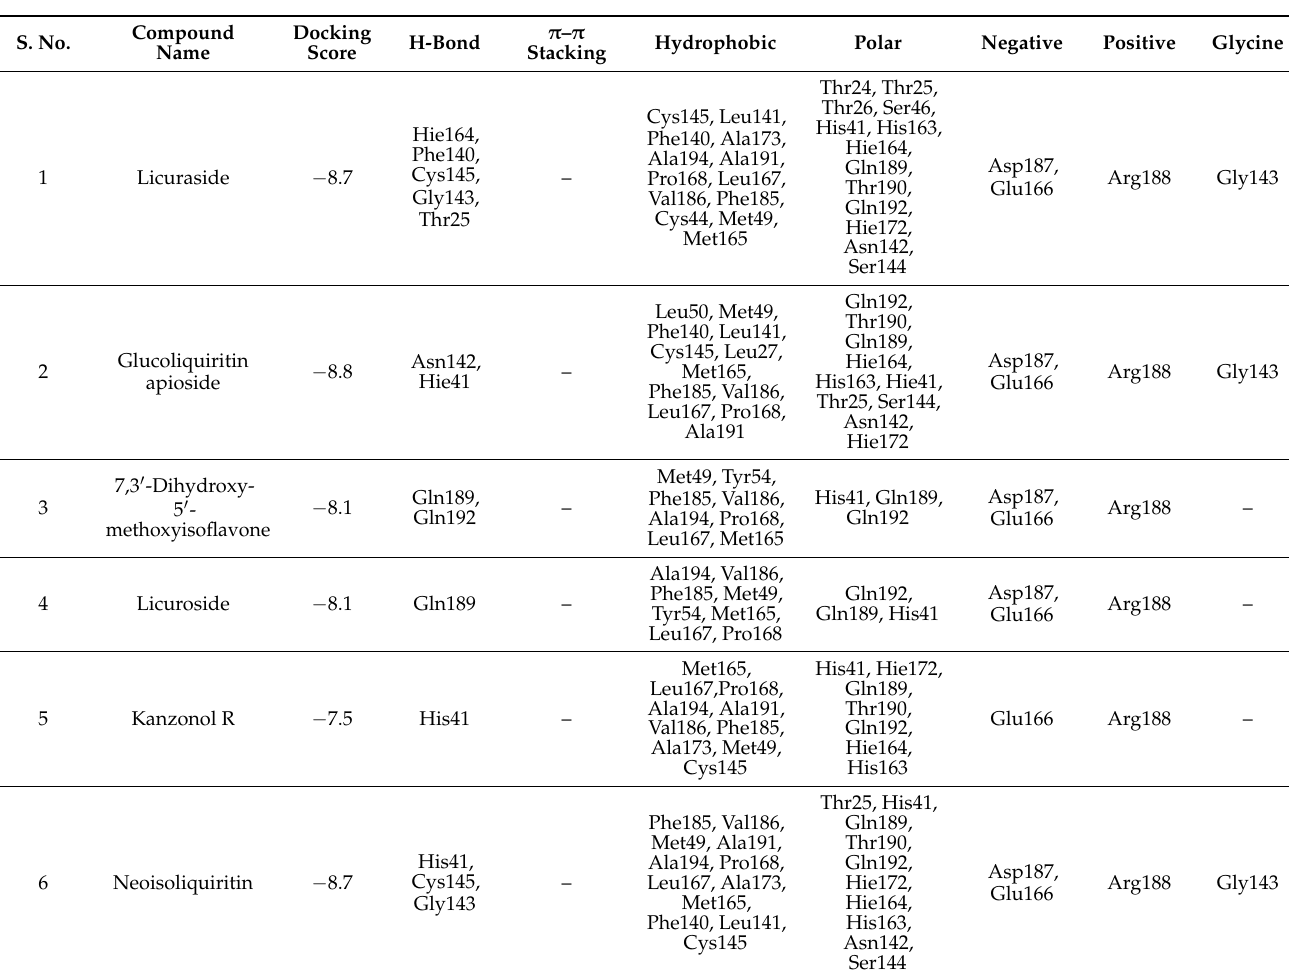
Table 1. Intermolecular interactions of selected docked compounds and reference ligand in the catalytic pocket of SARS- CoV-2 M pro